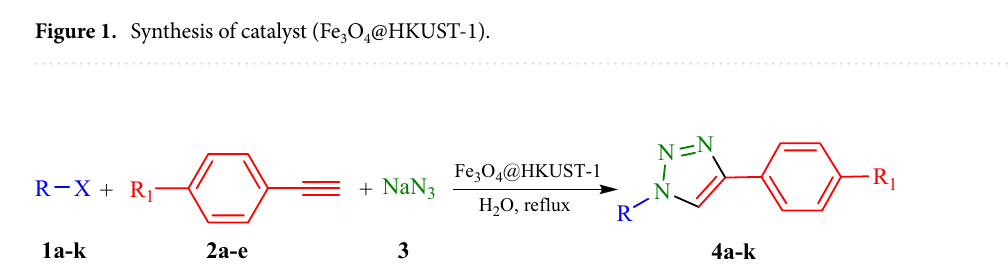
Figure 1. Synthesis of catalyst (Fe 3 O 4 @HKUST-1).